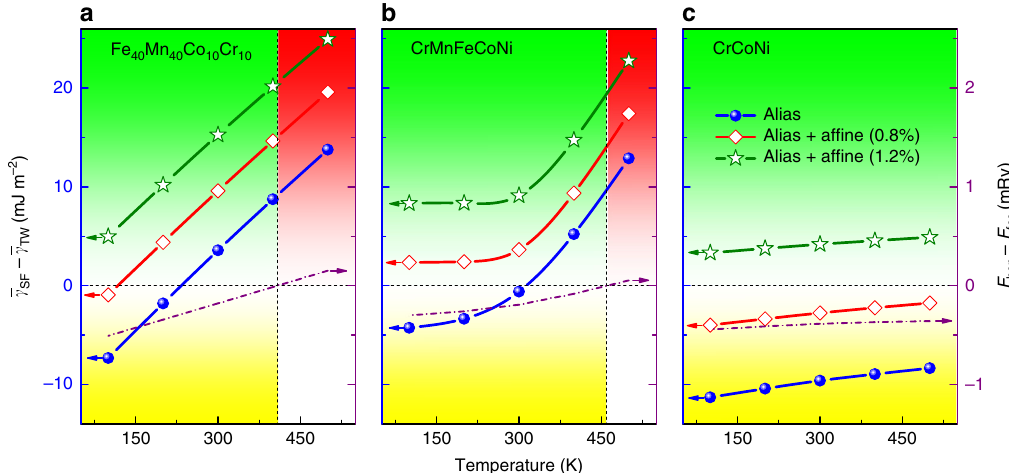
(cid:1) (cid:3) . a – c show the results for Fe 40 Mn 40 Co 10 Cr 10 , CrMnFeCoNi, and CrCoNi (cid:2) (cid:1) γ SF TW F ) are plotted by dash-dot lines for comparison. Solid lines with symbols denote (cid:1) γ hcp (cid:2) fcc